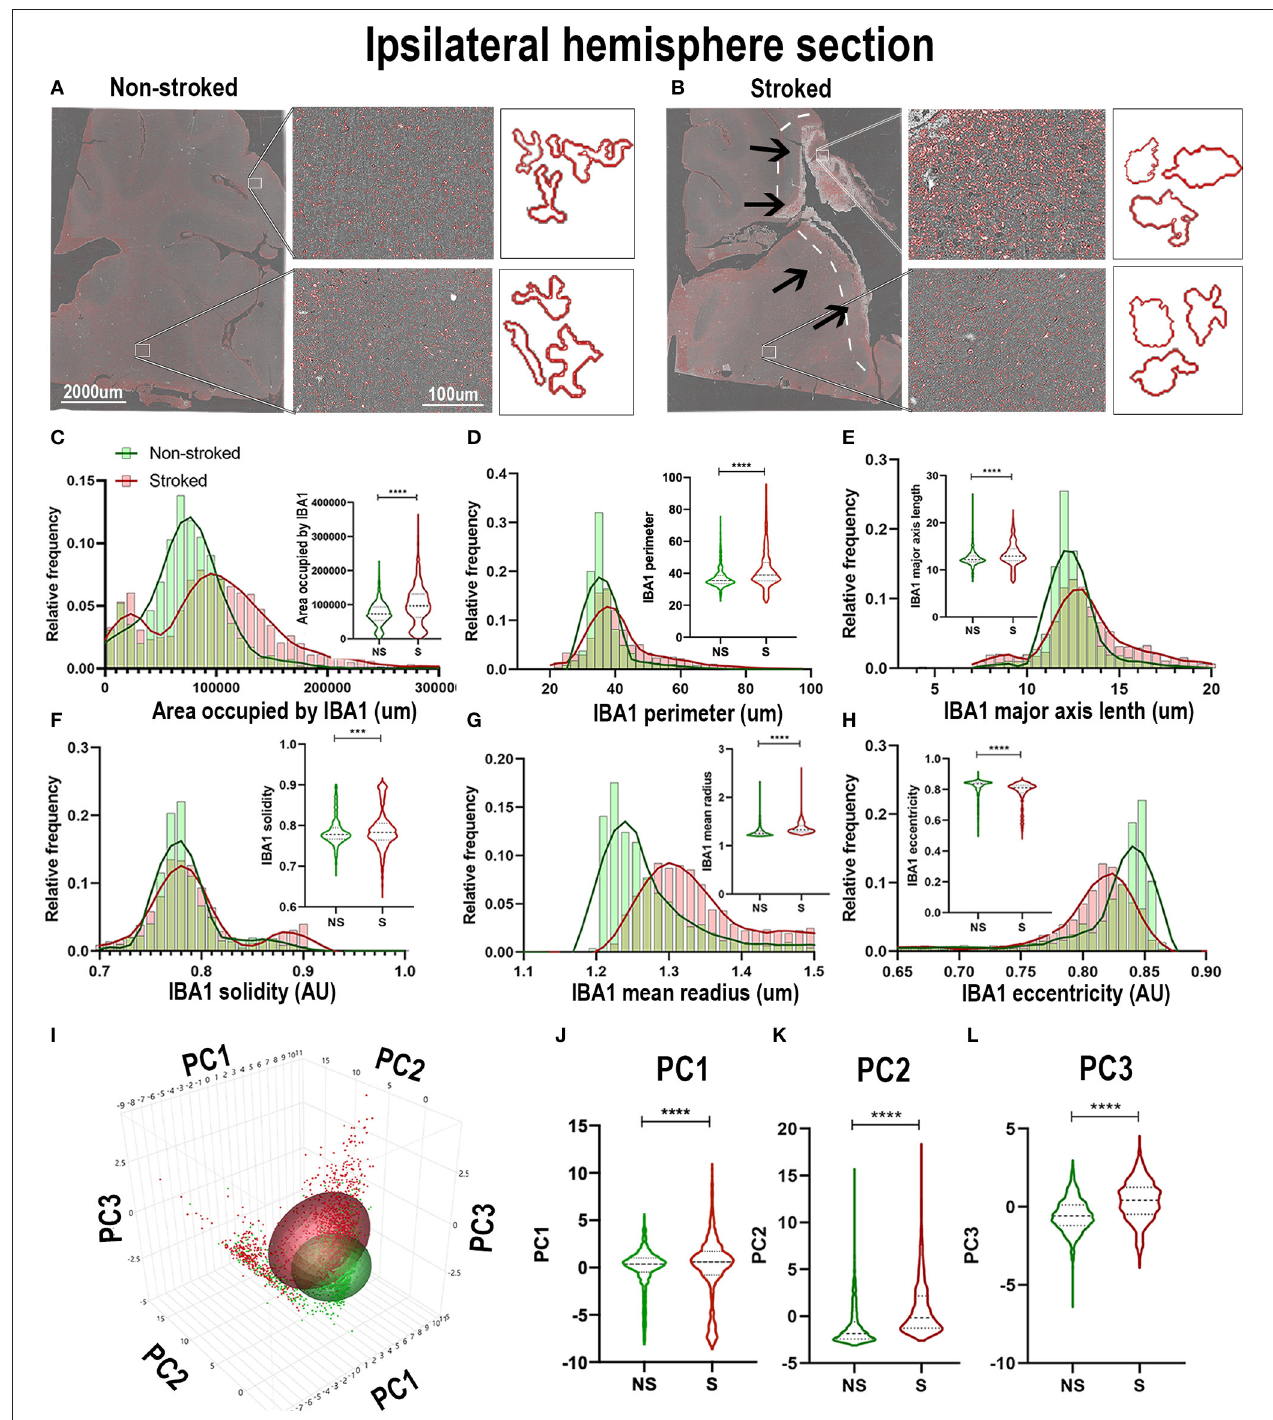
FIGURE 2 | IBA1 + areas transitioned to a more ameboid and swollen morphology after stroke in the ipsilateral hemisphere. Visual differences in density and morphological changes of IBA1 + areas were observed between NS and S animals (A,B) . Arrows indicate location of stroke lesion (B) . Significant ( p < 0.0001) increases in IBA1 + area occupied (C) , perimeter (D) , major axis length (E) , solidity ( F ; p = 0.0008), and mean radius (G) were observed in hemisphere section of S ( n = 1,860 ROIs) compared NS ( n = 1,362 ROIs). There was a significant ( p < 0.0001) decrease observed in eccentricity (H) of IBA1 + ROIs in hemisphere section analysis in S animals compared to NS animals. PCA (I) analysis showed significant ( p < 0.0001) increases in PC1 - PC3 (I–L) in S compared to NS animals. ** p < 0.001 and **** p < 0.0001.